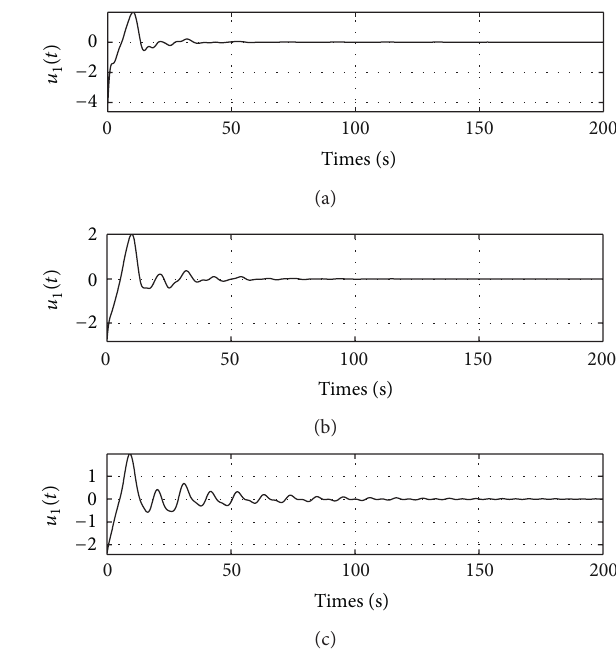
Figure 6: Effect of prediction horizon on displacement response: (a) Case 1 ( 𝑇 = 10 ), (b) Case 2 ( 𝑇 = 20 ), and (c) Case 3 ( 𝑇 = 30 ).